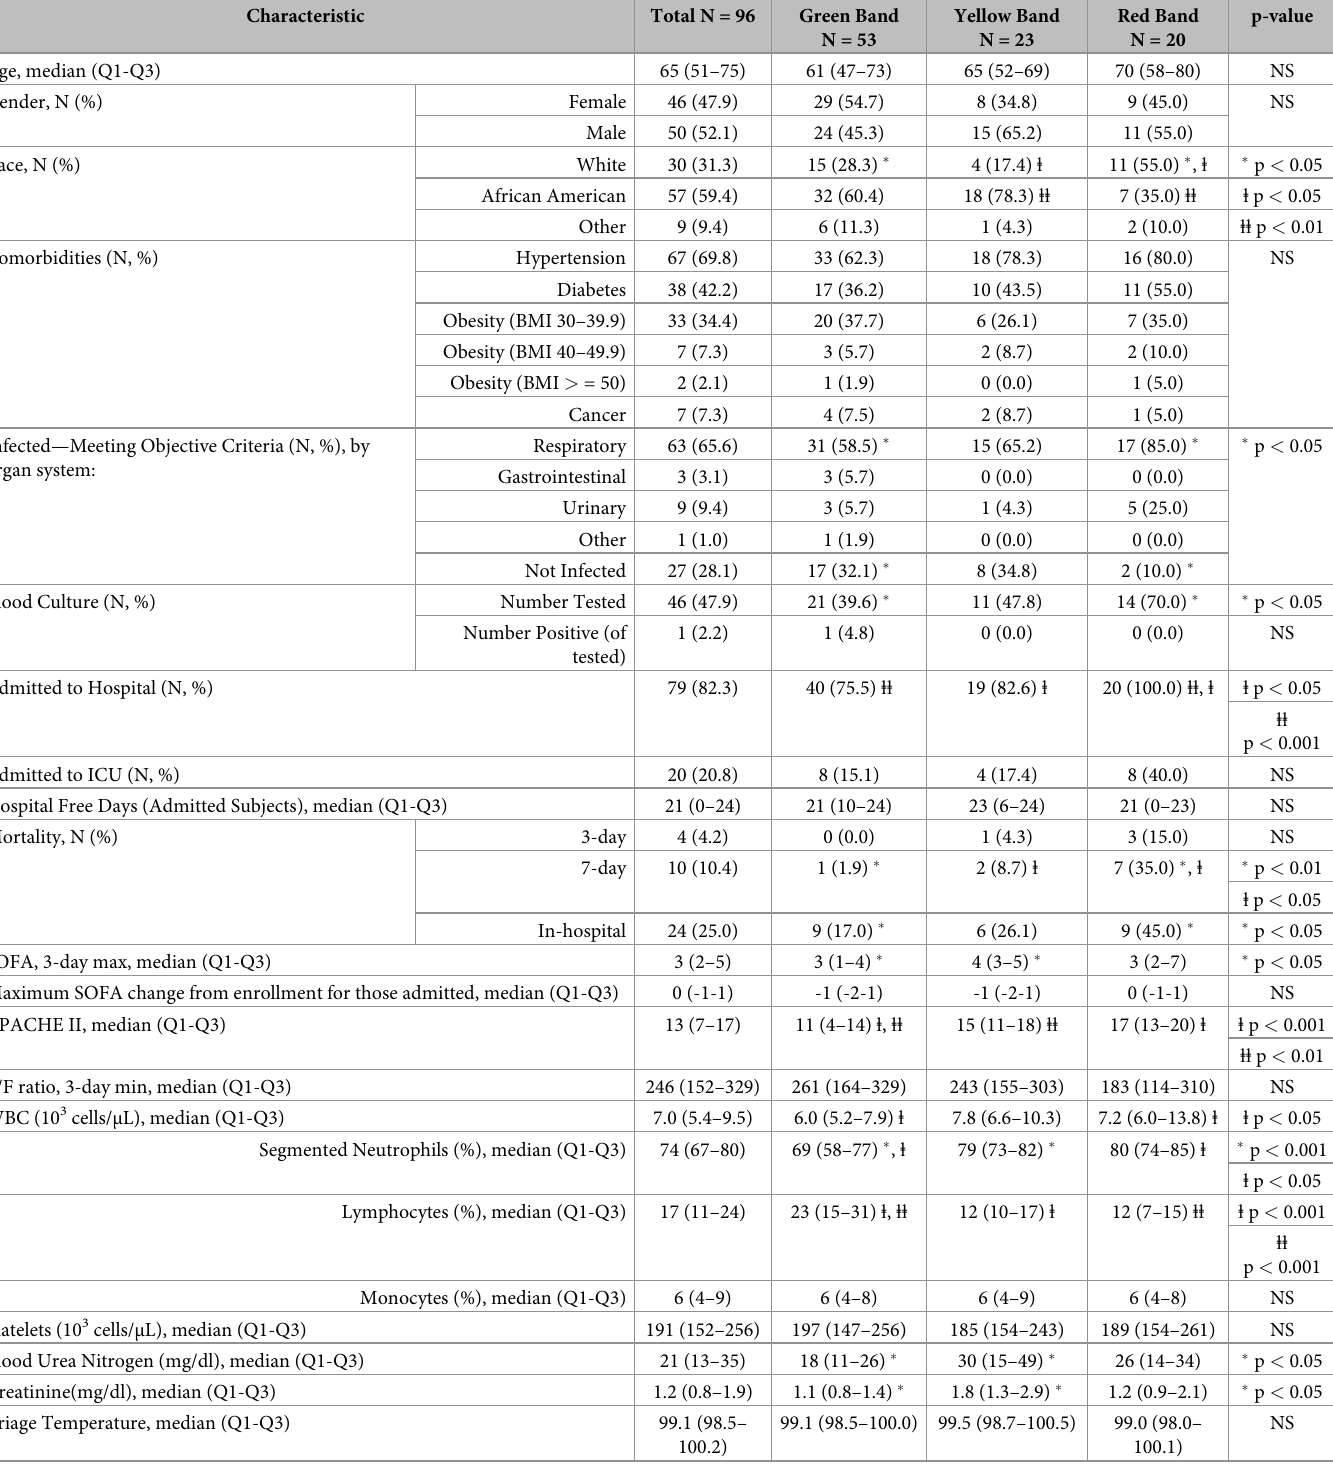
Table 2. Baseline characteristics and selected outcomes of SARS-CoV-2 positive patients (total) as well as stratified by ISI interpretation